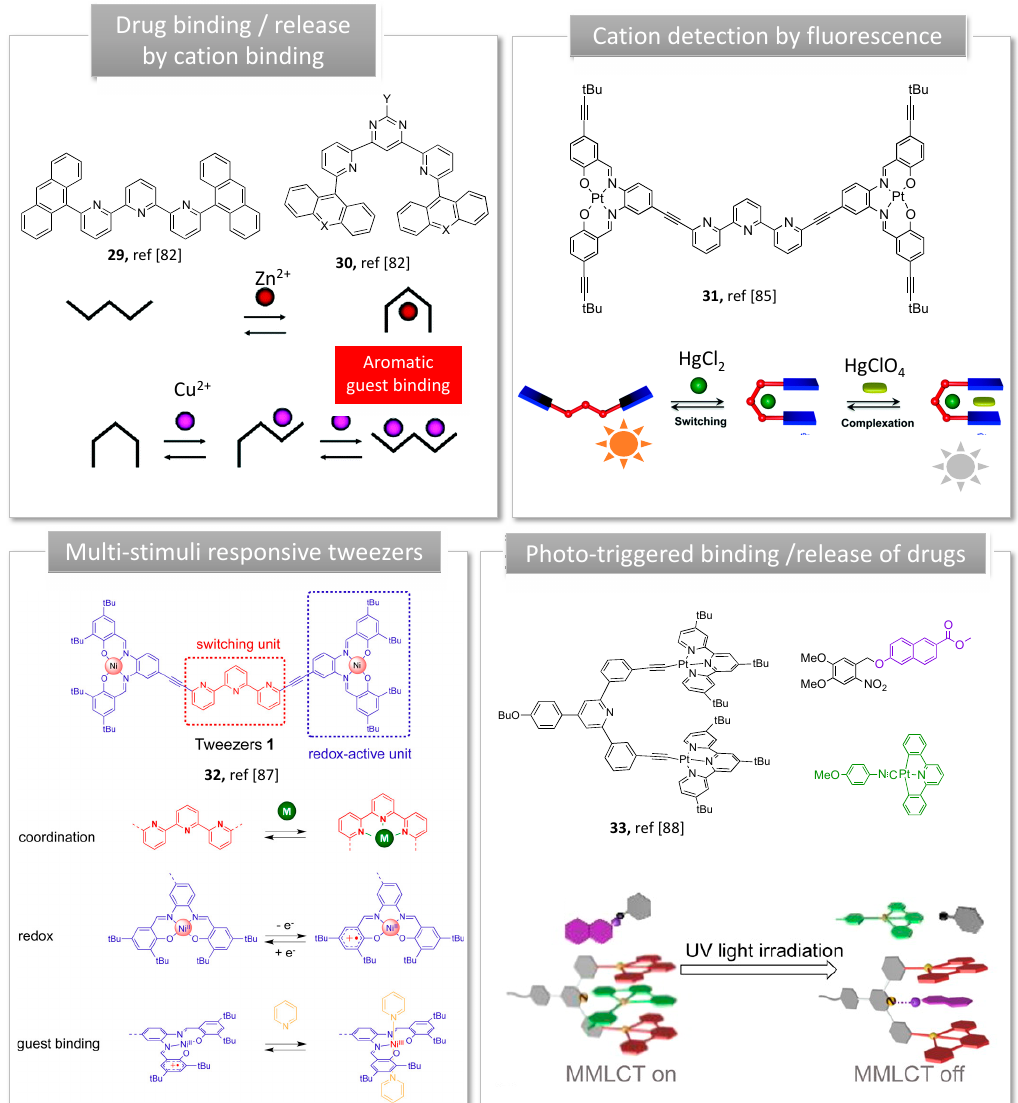
Figure 8. Examples of metal-switching tweezers. Adapted from [82,85–87].